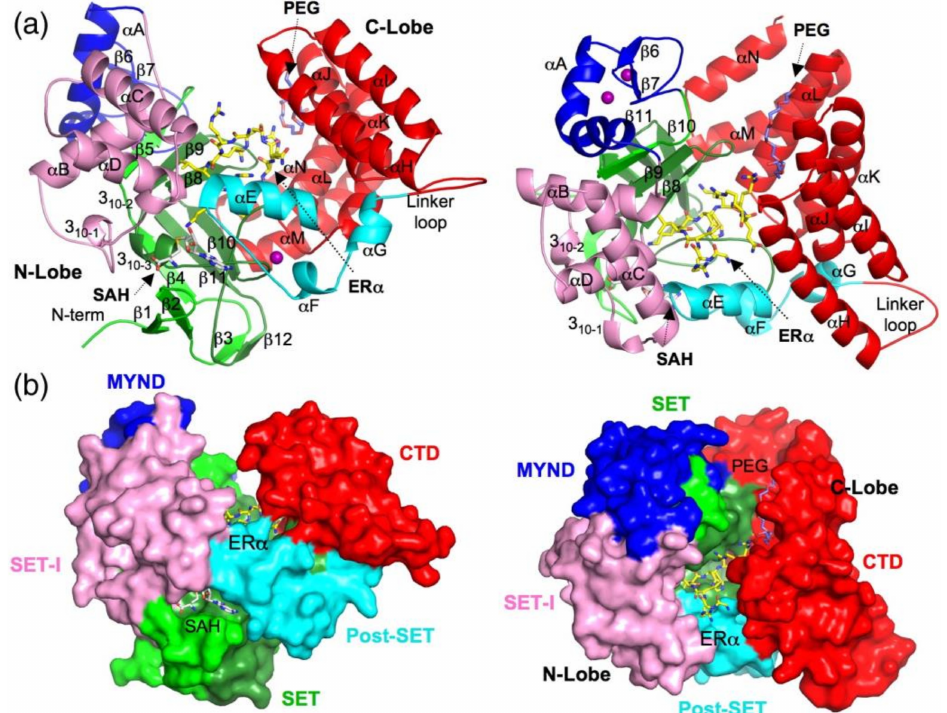
Figure 8. The structure of the SMYD2, bound to the ER α peptide and SAH. ( a ) A ribbon diagram is shown of the SMYD2–ER α structure, side view (left) and top view (right). The S-sequence, MYND, SET-I, core SET, post-SET, and CTD are indicated in light green, blue, pink, green, cyan, and red. The α -helices and β -strands are labeled numerically. The ER α peptide, SAH, and a polyphenol glycol molecule (PEG) are displayed as sticks, with their carbon atoms colored yellow, white, and light blue. Zinc ions are shown by spheres and are colored purple. ( b ) A surface representation of the SMYD2–ER α structure, side view (left) and top view (right). SMYD2 is represented by the molecular surface, which is colored according to indicated domains. The ER α peptide, SAH, and PEG molecules are represented as stick molecules, as in ( a ). Image licensed by CC-BY 4.0 Ref.